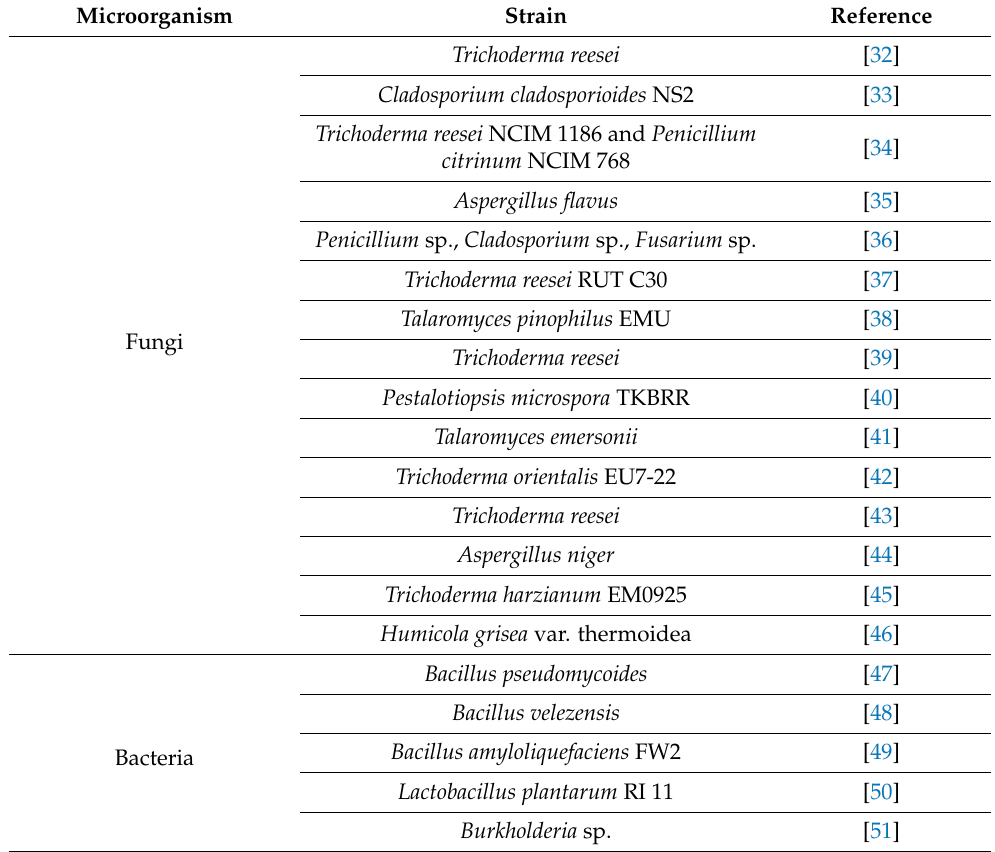
Table 2. Recent prominent strains used in the research of lignocellulolytic enzyme